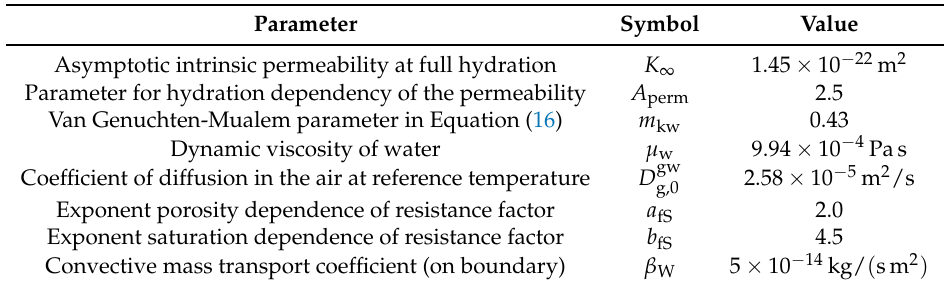
Table 5. Parameters for water transport